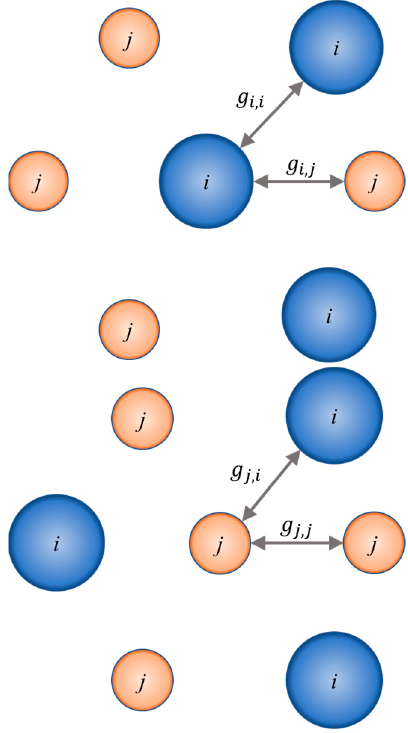
Figure 6. Two types of molecular clusters or cells of binary liquid mixtures. Each molecule of type i or of type j is regarded as being surrounded by molecules of both types in proportions determined by the Gibbs energies of interaction, g jj , which are indicated in the diagram.